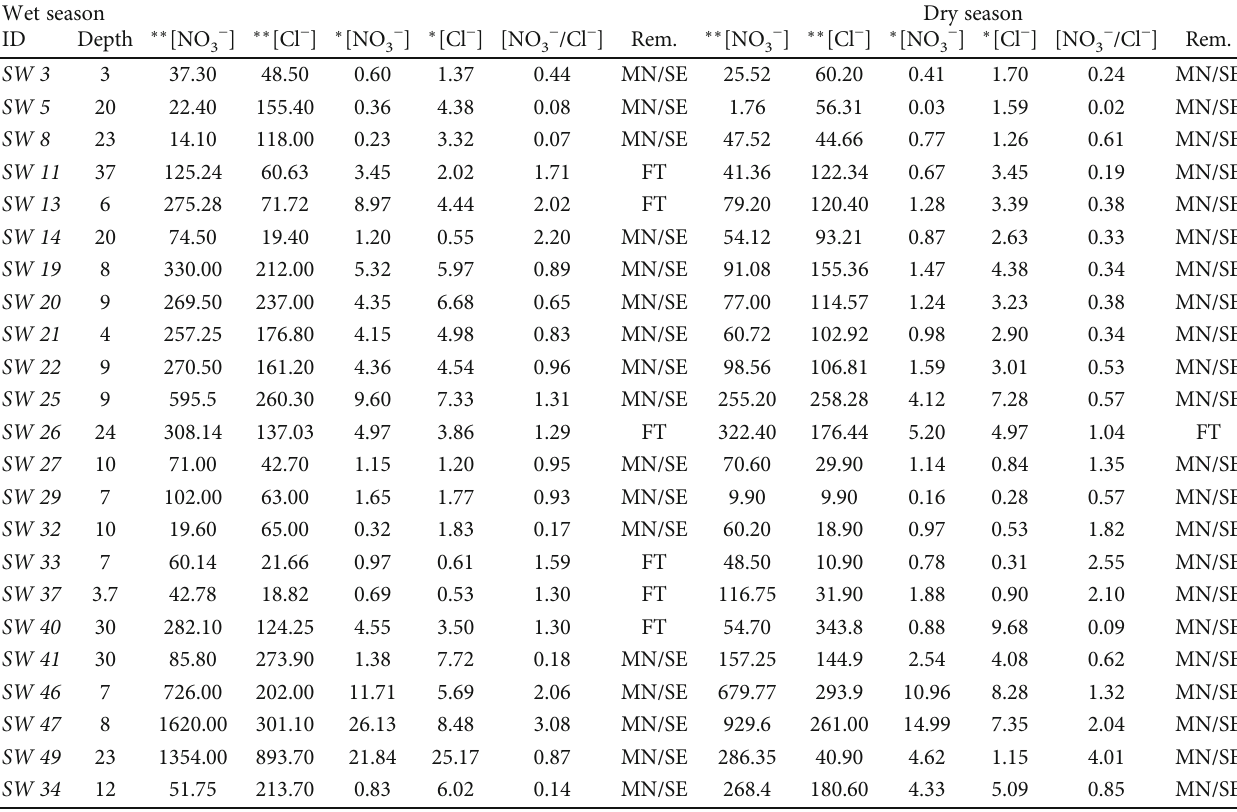
Table 2: Identi fi ed nitrate sources on shallow wells using the nitrate-chloride ratio during the wet and dry seasons. Wet season Dry